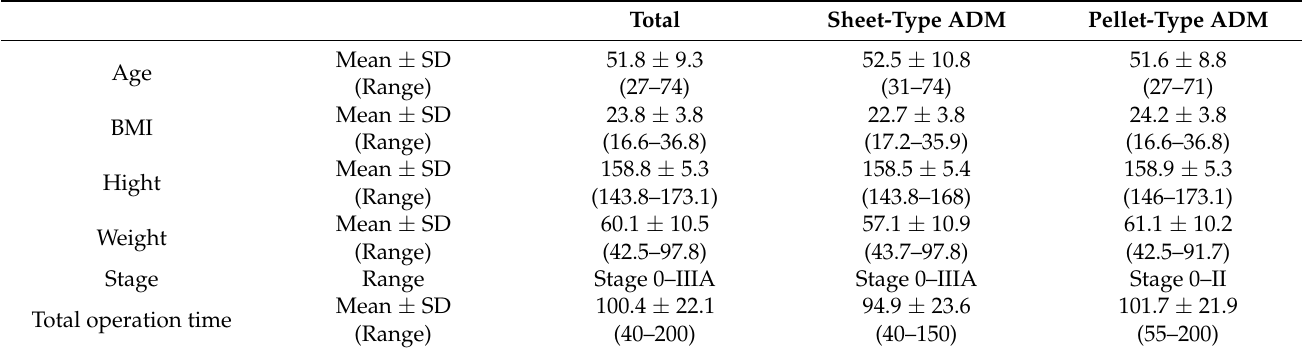
Table 1. Patient characteristics.